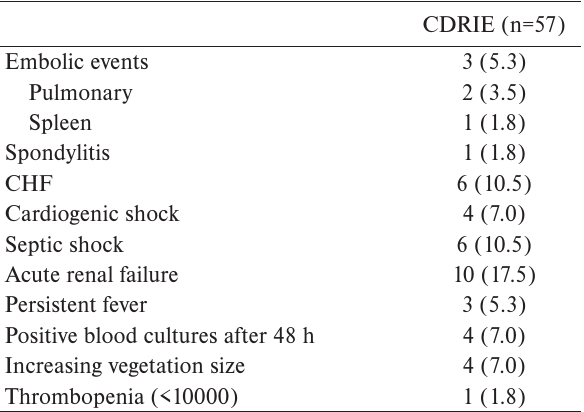
Table 3. Complications under